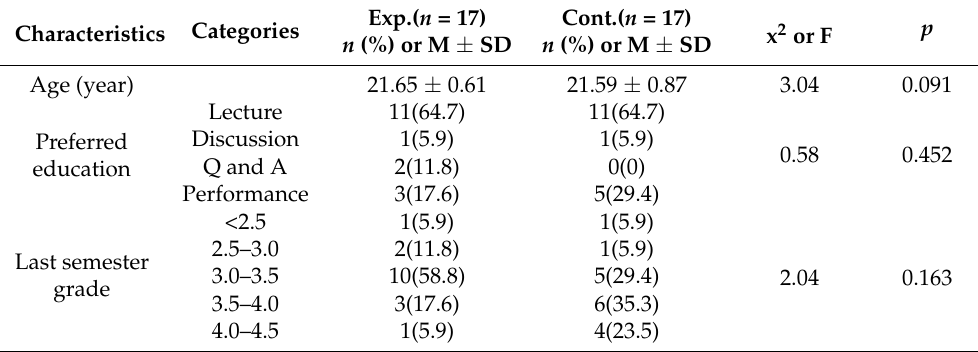
Table 1. General Characteristics of the Participants ( n = 34).